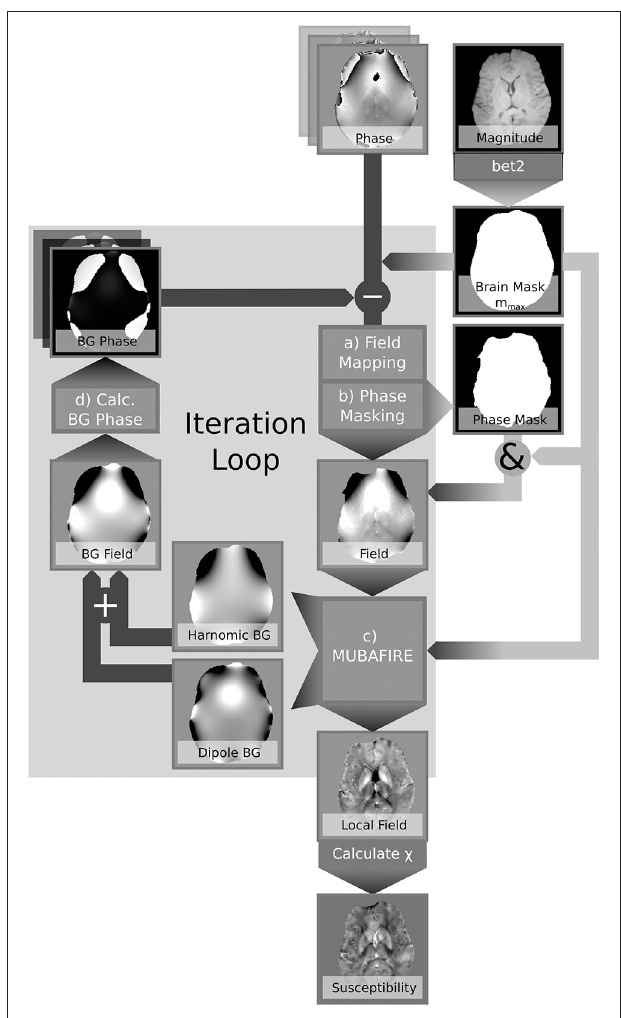
FIGURE 2 | Processing scheme illustrating the iterative correction applied by